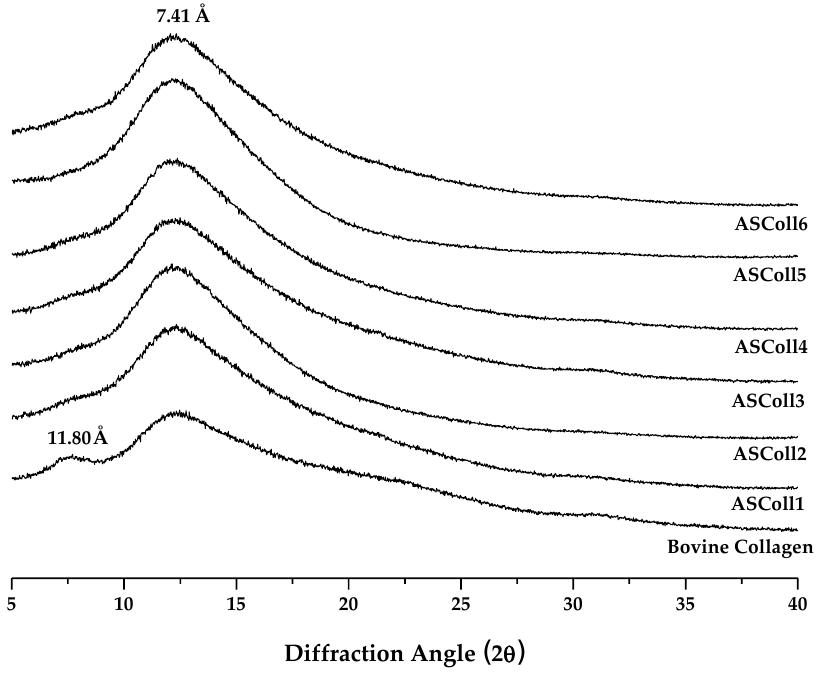
Figure 3. X-ray Diffraction spectra of the ASColl and the commercial type I collagen from bovine skin. The circular dichroism spectroscopy allows the study of the proteins’ secondary structure by measuring the absorption difference between the left-handed and the right- handed circularly polarized light, defining the collagen structure [50]. This technique can also be used to determine the denaturation temperature (T d ) of proteins, when the circular dichroism spectra is recorded as function of temperature [51]. As shown by Figure 4A, the ASColl samples presented a similar spectrum between them, being notably different from the bovine collagen spectrum. Regarding the ASColl spectra, at 25 ◦ C, no positive peak can be observed and only a negative peak can be found, between 198 nm and 205 nm, which indicates the prevalence of random coil conformation and the absence of a triple-helix structure [51]. However, at this same temperature, the bovine skin collagen spectrum presents both a negative and positive peak, around 200 nm and 224 nm, respectively, which suggests the preservation of its native, non-denatured, structure [50,51], which corroborates the interpretations based in the XRD results.